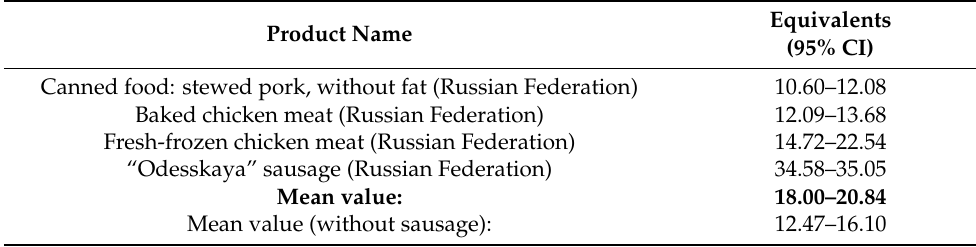
Table 8. ARP values for meat and products of its processing. Product